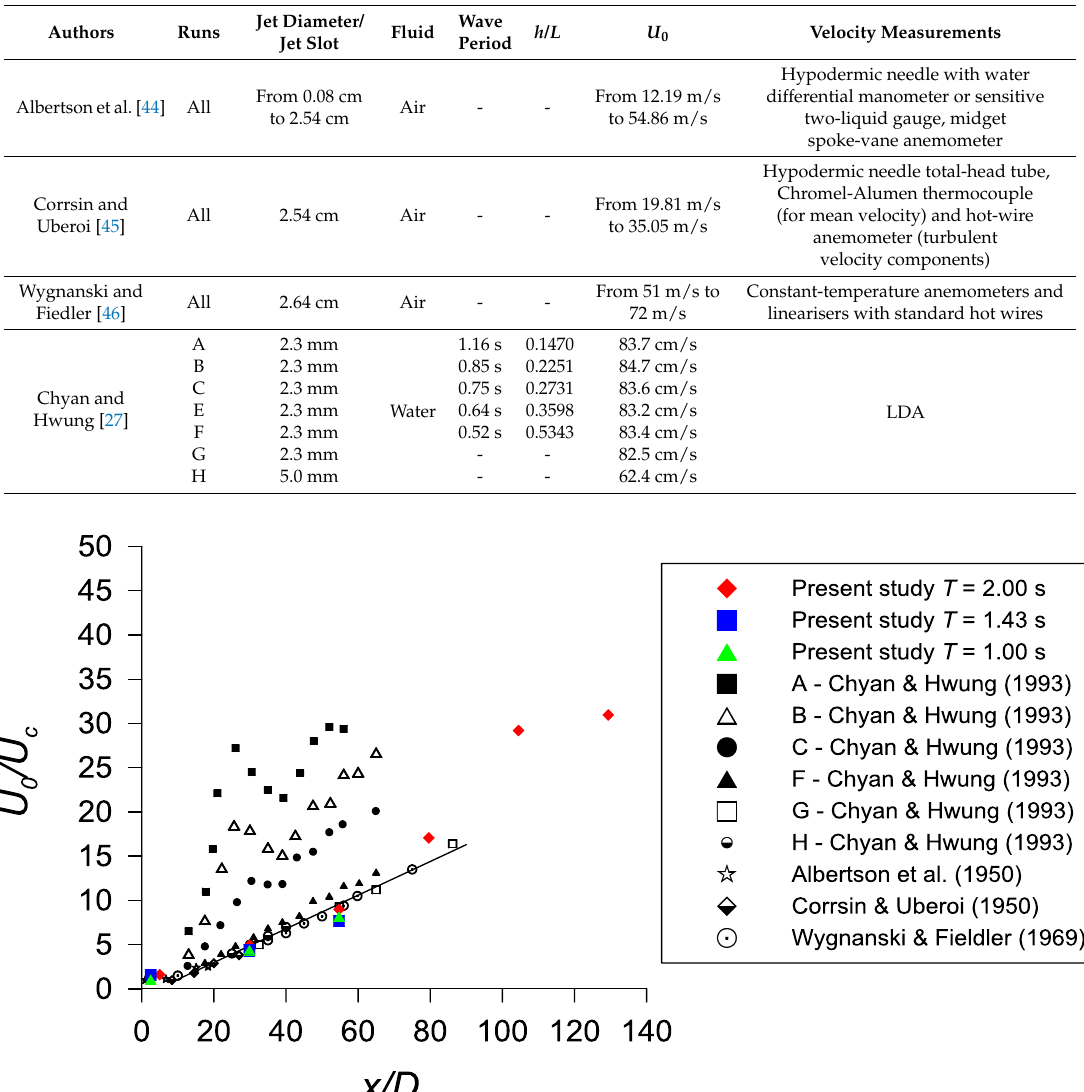
Table 2. Main flow conditions and instrumentation used by the authors of the previous investigations.